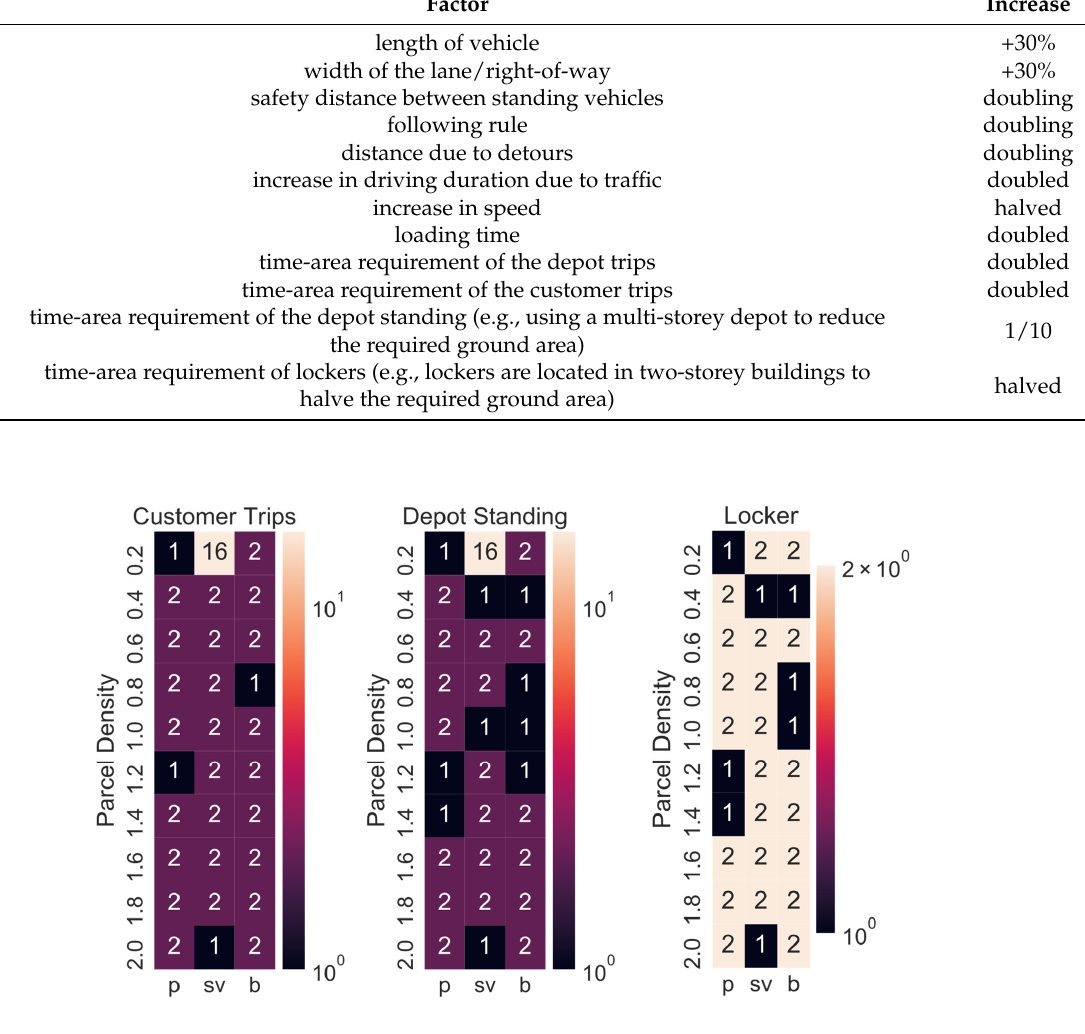
Figure 12. Increase in the optimal number of CDPs (2: doubled number of CDPs).